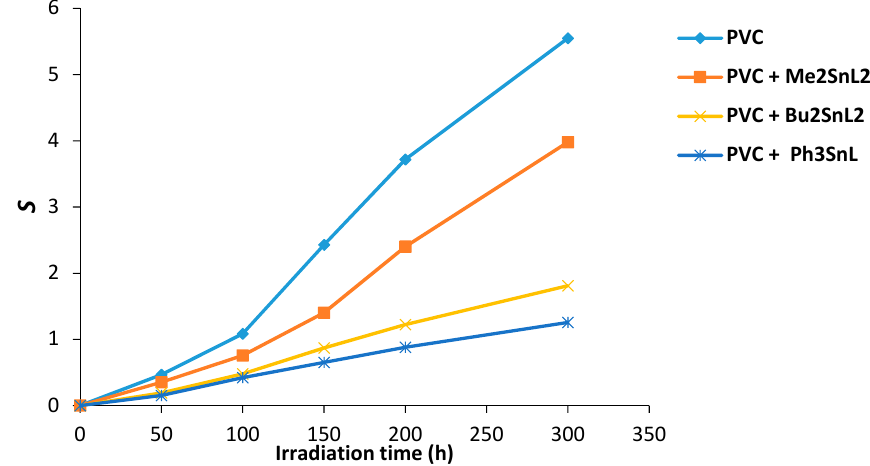
Figure 8. Changes in the main chain scission ( S ) for PVC films versus irradiation time.